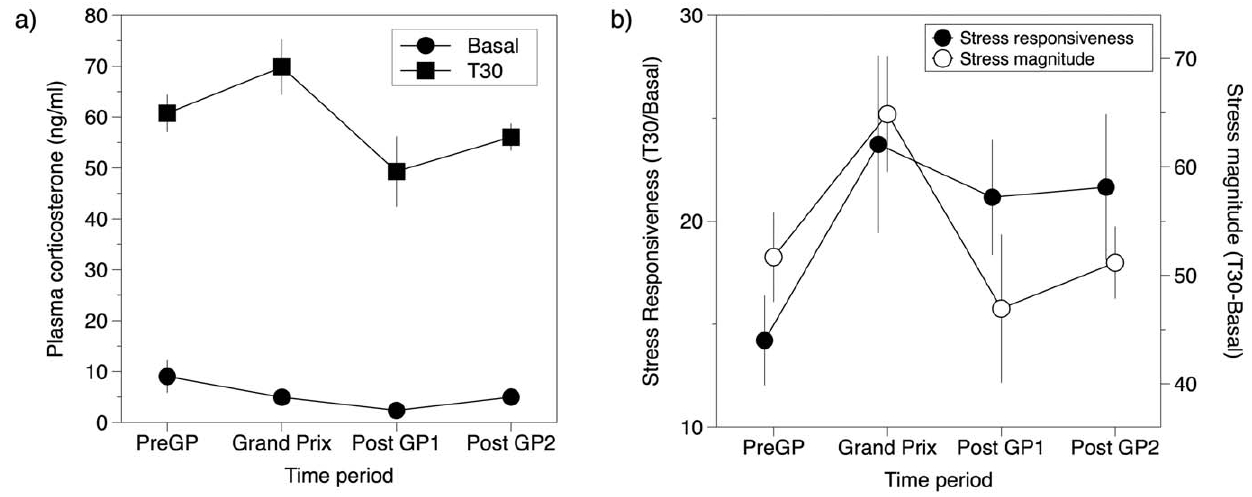
Figure 4. Fluctuations in basal and stress-induced (T30) corticosterone in captured black swans over the period of the study. Panel a) shows plasma corticosterone concentration (ng/ml) of black swans captured before the Grand Prix (Pre GP; n=20), during the Grand Prix (Grand Prix; n=12), one week after the Grand Prix (Post GP1; n=9) and two weeks after the Grand Prix (Post GP2; n=14) periods. Filled circles represent basal corticosterone levels, filled squares corticosterone levels after 30 min of restraint (T30). Panel b) shows corticosterone stress responsiveness, estimated as T30/Basal corticosterone levels for each time perriod (filled circles) and corticosterone stress magnitude, estimated as T30-Basal corticosterone levels (open circles).